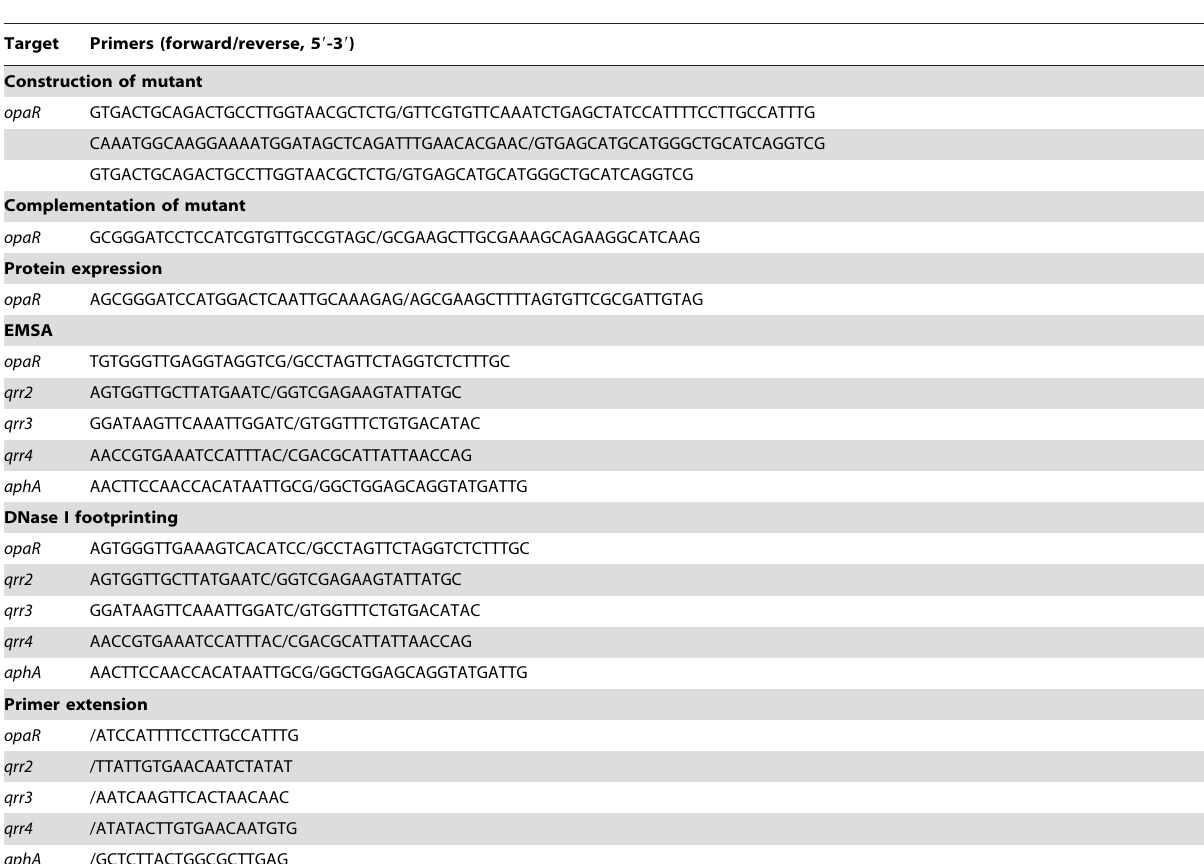
Table 1. Oligonucleotide primers used in this